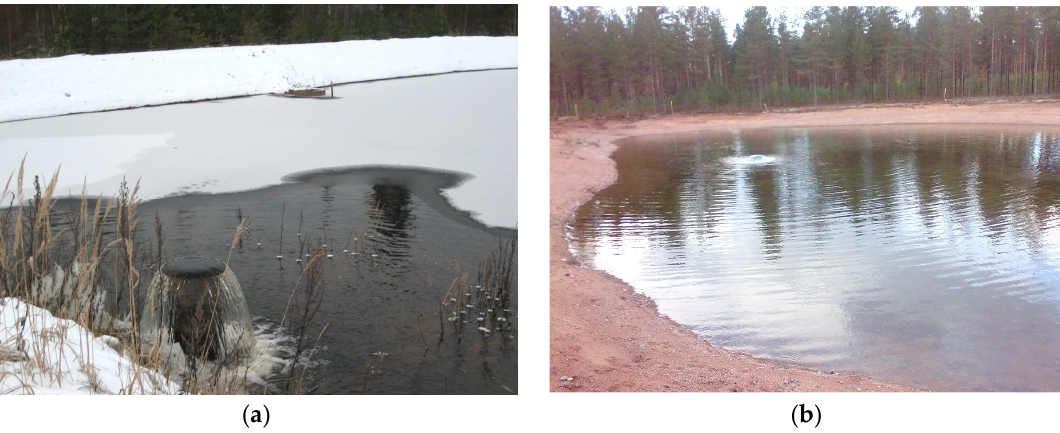
Figure 4. ( a ) Basin infiltration at Kuivala MAR plant in November; ( b ) Basin infiltration trials at Virttaankangas MAR plant in October 2009 (Photographer, P. Jokela).